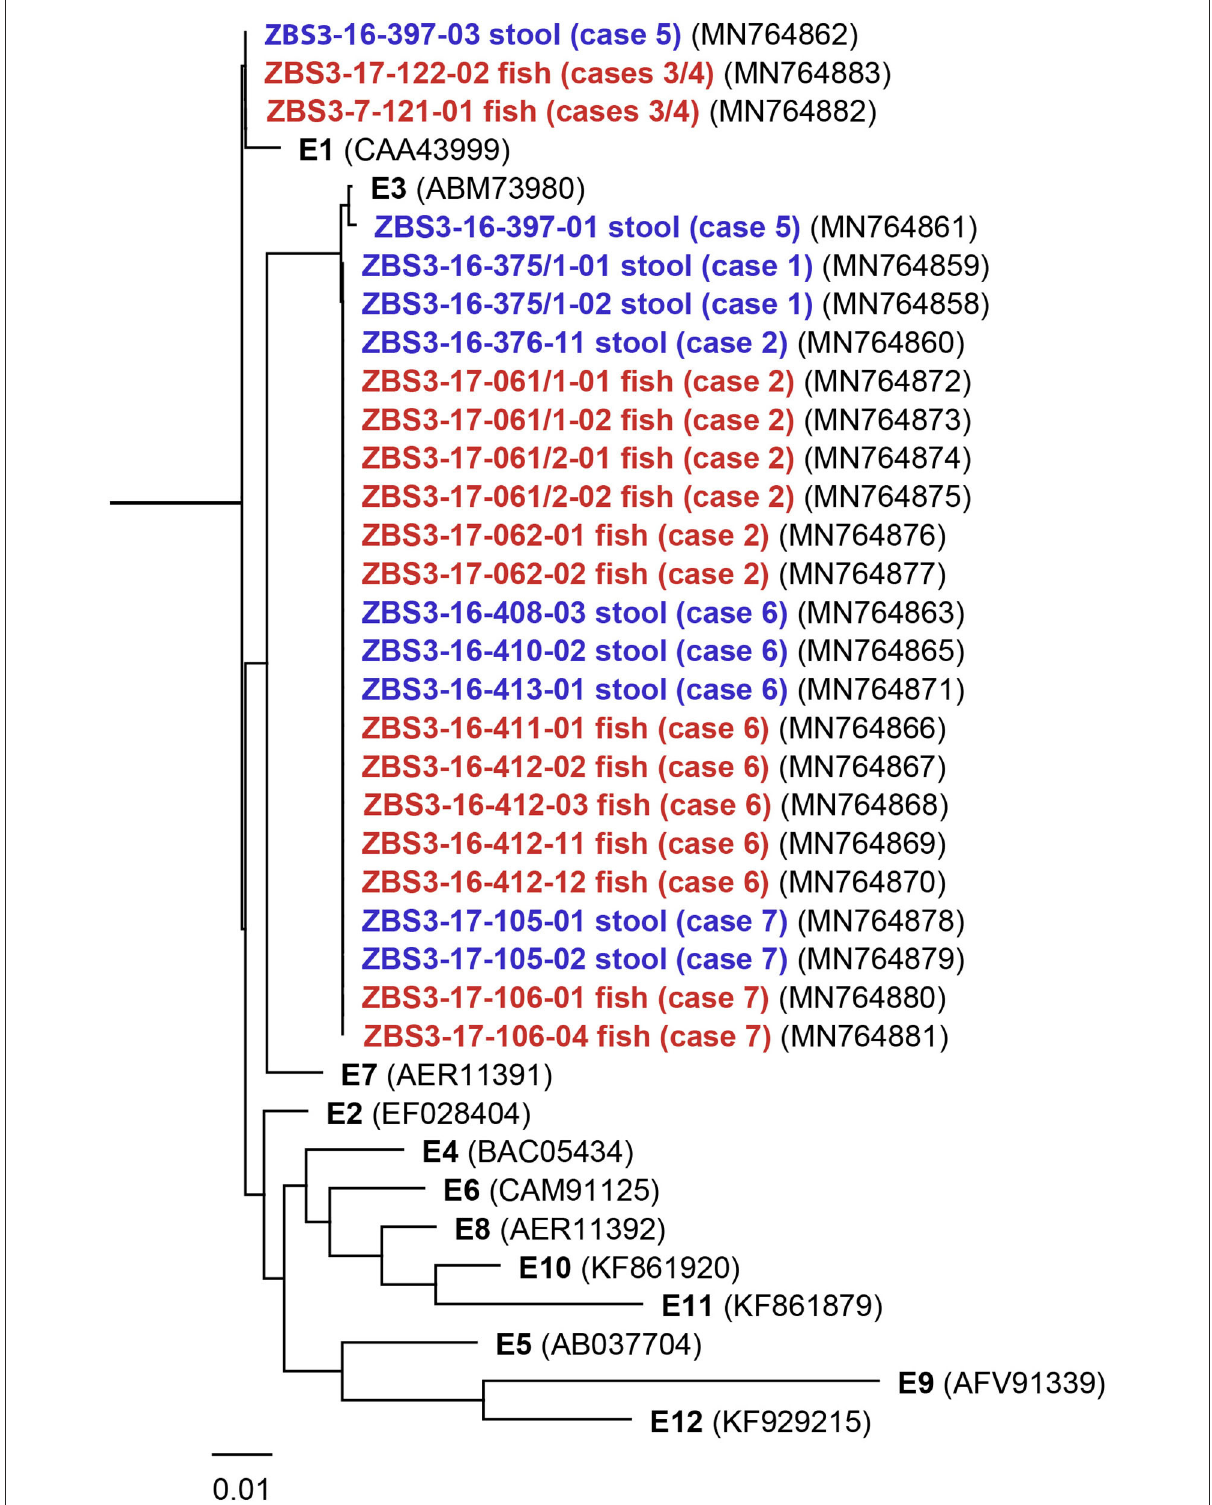
FIGURE2 Dendrogram of the translational alignment of the 12 described prototypic BoNT/E subtypes (E1 to E12; black) compared to the obtained BoNT/E subtype amino acid sequences from implicated stool (blue) or fish (red) samples. The scale bar indicates amino acid substitutions per site. GenBank accession numbers are given in